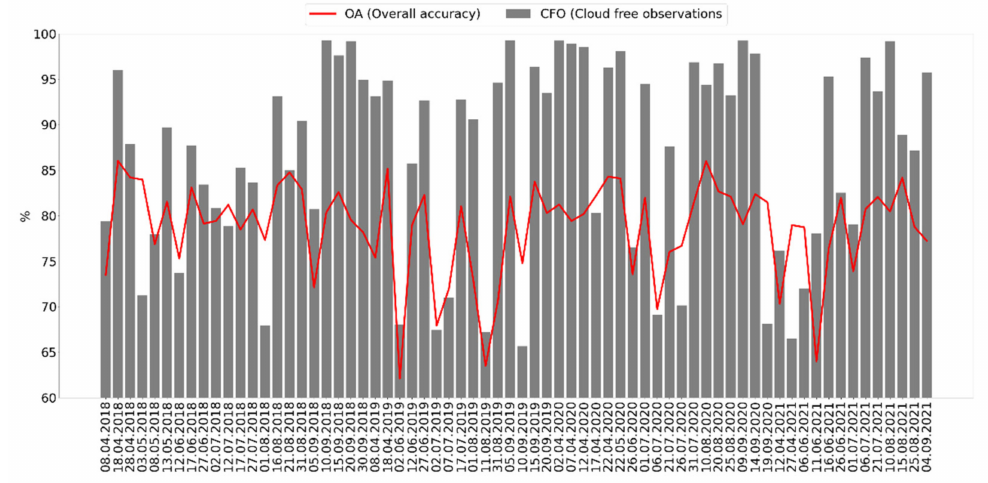
Figure 4. Overall accuracy and cloud cover of single date images.